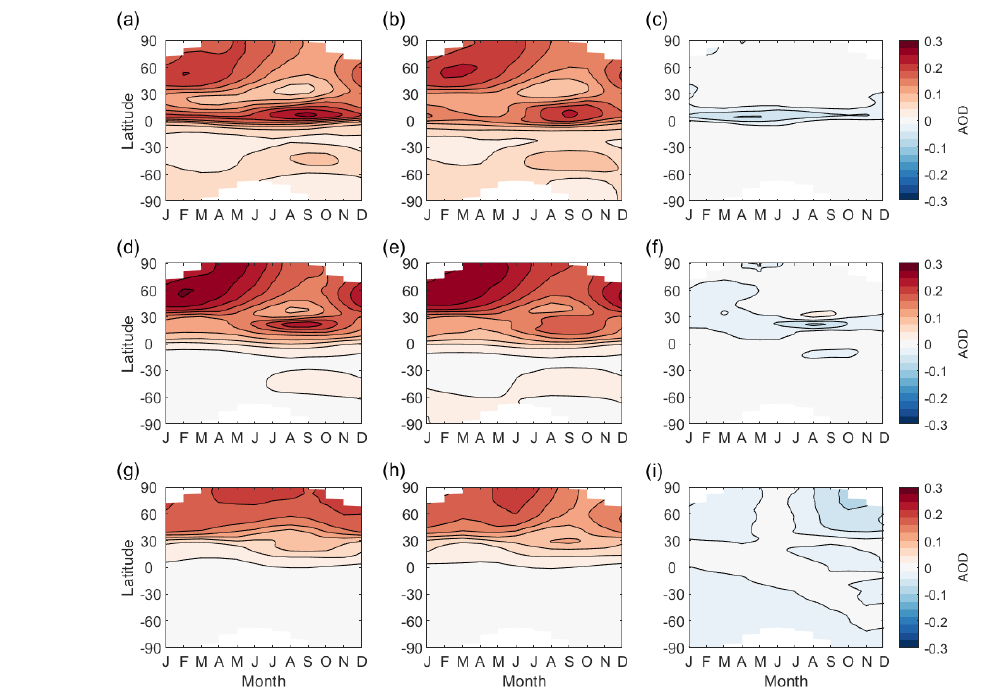
Figure 3. Comparison of simulated AOD patterns and the best approximation to these AOD patterns obtained from a linear combination of other injection choices within the set of 29 cases considered here. From top to bottom are the spatiotemporal AOD patterns for injections at 7.5, 22.5, and 37.5 ◦ N, respectively. In each horizontal panel, plots from left to right are the AOD pattern obtained from CESM1(WACCM) simulations, the AOD pattern approximated using the set of 29 injection choices, and the difference between these two patterns. The angles between the simulated AOD pattern and the AOD pattern approximated using the set of 29 injection choices are 7.6, 5.9, and 6.1 ◦ , respec-